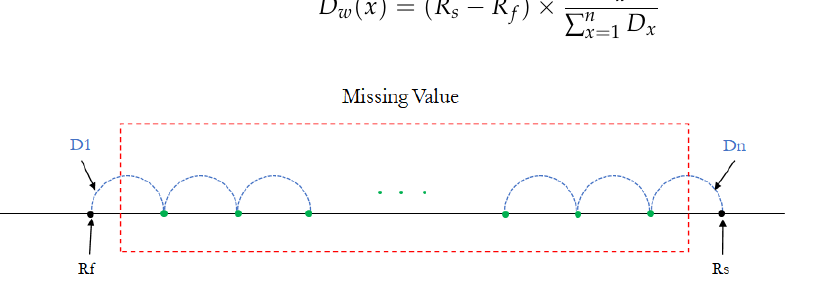
Figure 12. Concept of missing data